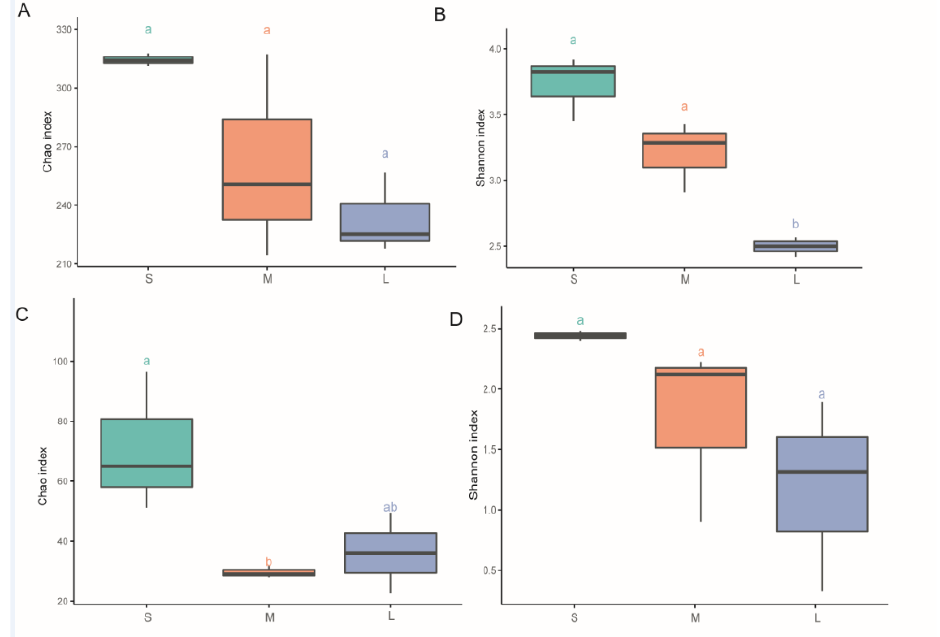
Figure 3. Diversity indices in different developmental phases of Paphiopedilum armeniacum. ( A , B ) Chao and Shannon indices of the bacterial community, respectively; ( C , D ) Chao and Shannon indices of the fungal community, respectively. S, M, and L represent the seedling stage, vegetative growth stage, and reproductive growth stage of Paphiopedilum armeniacum , respectively. Lowercase letters a and b in the graphs indicate significant differences between the different samples, determined based on Tukey’s test ( p < 0.05).